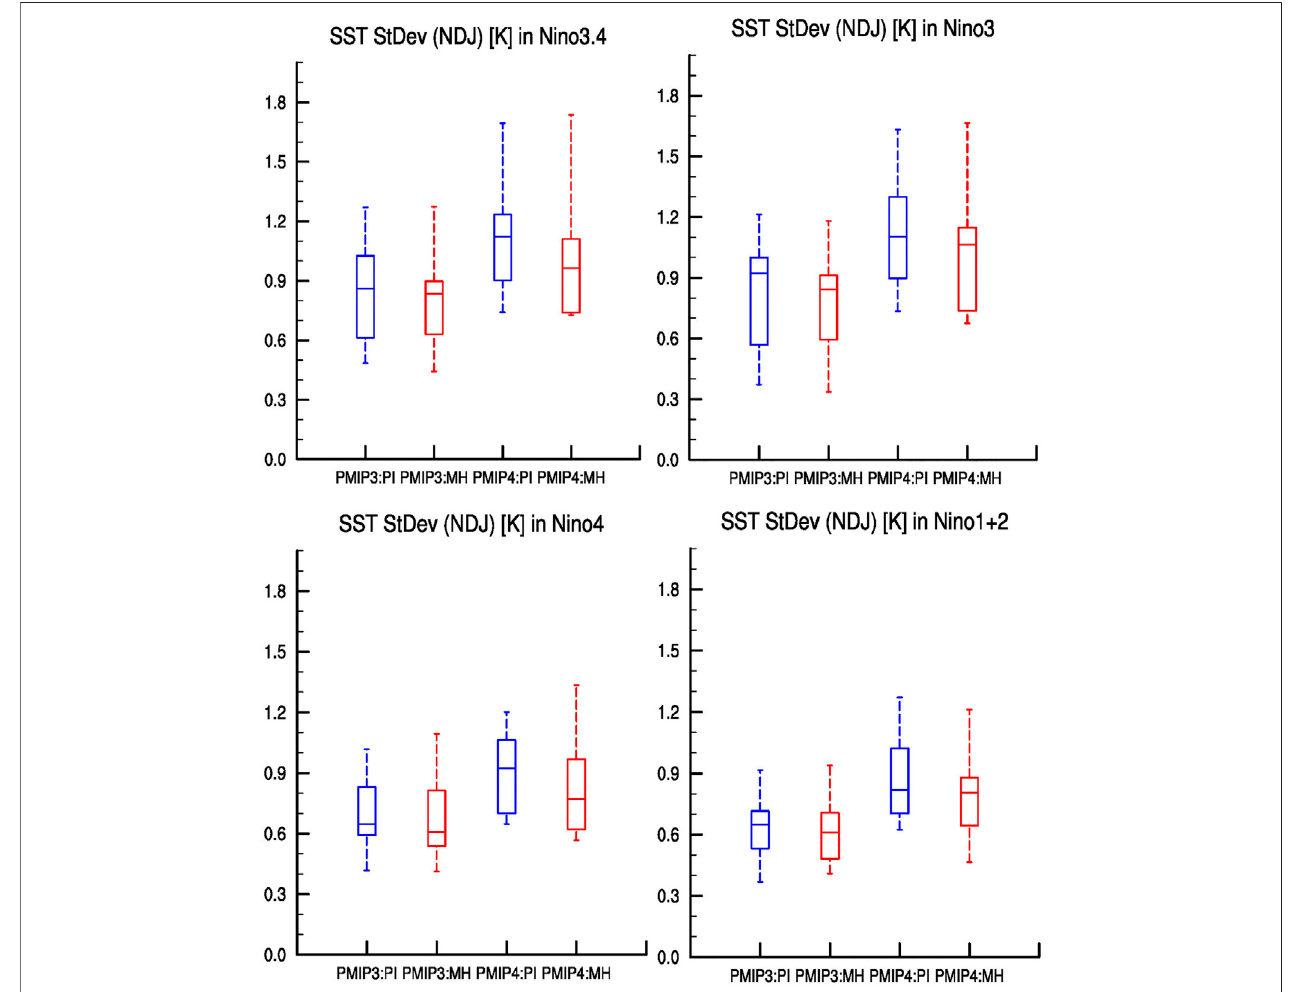
FIGURE8 | Boxplots for standard deviation of various ENSO indices for PMIP3 and PMIP4models. Blue boxes indicate the PIsimulations, and red boxes indicate theMHsimulations.Theupperandlowerboundsofeachboxrepresent25thand75thpercentiles,respectively;thesolidlineinthemiddleofeachboxisthemedian;and whiskers are the maximum or minimum, respectively. De fi nitions for each area: Niño1+2 (90 o – 80 o W, 0 o – 10 o S). Niño3 (150 o – 90 o W, 5 o S – 5 o N), Niño3.4 (170 o – 120 o